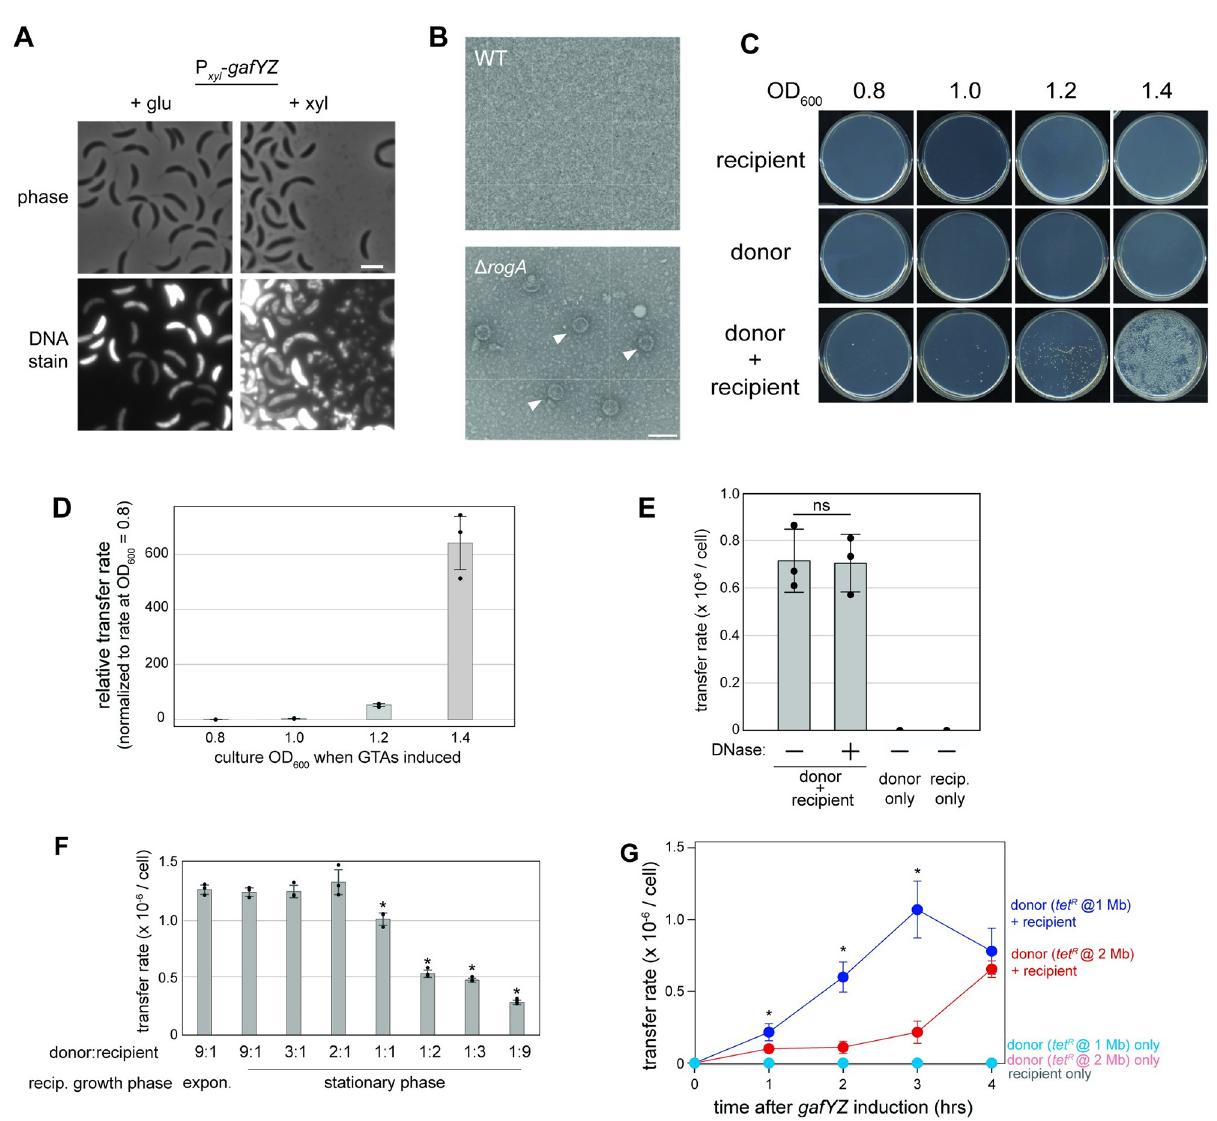
Fig 4. GTAs are released into the supernatant and can transfer genetic material. (A) Micrographs of cells bearing P - gafYZ on a high-copy vector xyl grown with 0.2% glucose or 0.3% xylose for 3 h. Samples were stained with SYBR-gold and imaged for fluorescence. Scale bar = 2 μ m. (B) Transmission electron micrographs of filtered supernatant from wild-type or Δ rogA cells in stationary phase. Scale bar = 100 nm. (C) Representative images of gene transfer with induction of gafYZ at different optical densities. (D) Quantification of the gene transfer rate of the tet R resistance marker from a donor - gafYZ on a high-copy plasmid ( n = 3, error bars indicate SD). Transfers were carried out with induction of gafYZ at different culture strain bearing P xyl densities as marked. Transfer rates are shown relative to transfer measured at cell density = 0.8. Data are available in S1 Data. (E) GTA-mediated gene transfer rates with or without addition of DNase. A total of 5 U/mL DNase I was added to donor culture for 1 h following induction, followed by 3 h co- culture with recipient strain ( n = 3, error bars indicate SD). ns = not statistically significant via t test. Data are available in S1 Data. (F) GTA-mediated gene transfer rates with donor and recipient cells at different ratios ( n = 3, error bars indicate SD). Recipient cells were also assayed when in exponential phase. � = p -value < 0.05 comparing data to “9:1 stationary” sample. Data are available in S1 Data. (G) Transfer rate of the tet R resistance marker from donors bearing P xyl - gafYZ on a high-copy plasmid and a tet R resistance marker either at a region of high packaging (1.0 Mb) or low packaging (2.0 Mb) ( n = 3, error bars indicate SD). Each donor and recipient strain were grown either alone or together in the presence of 0.3% xylose. � = p -value < 0.05 comparing data of same time point between the “donor ( tet R @ 1 Mb) + recipient” and “donor ( tet R @ 2 Mb) + recipient” samples. Data are available in S1 Data. GTA, gene transfer agent.